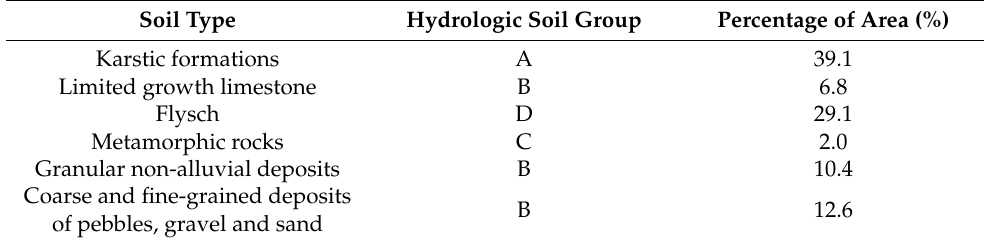
Table 1. Soil categories and hydrologic soil groups in the study basin. Soil